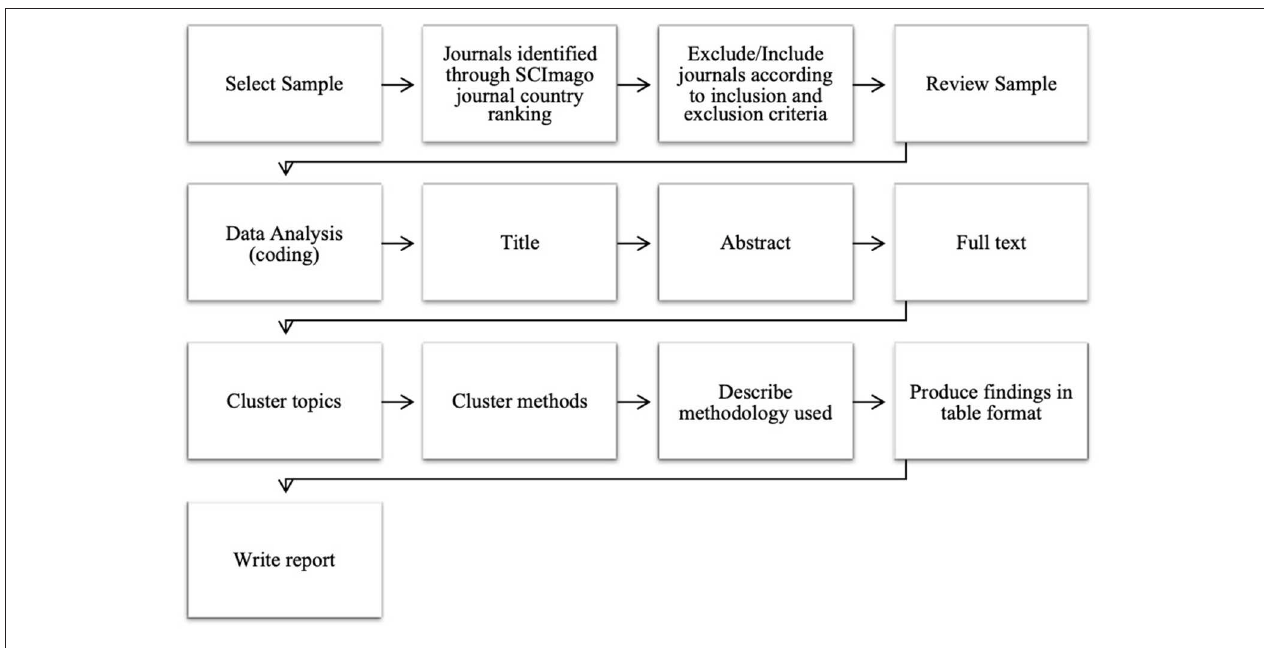
FIGURE 1 | Systematised review procedure.